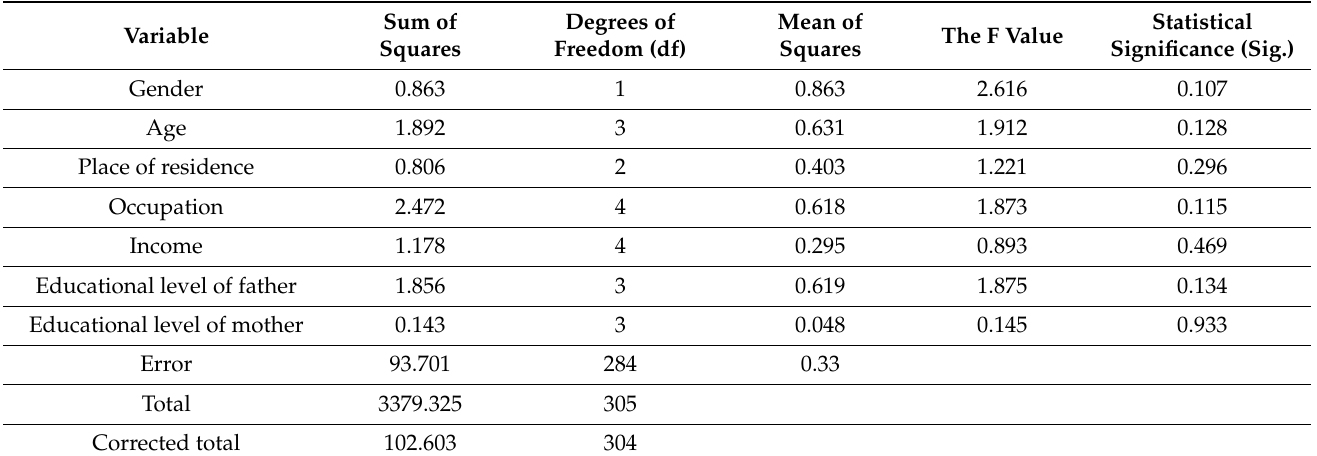
Table 5. MANOVA test of the difference in the level of the familial factors that reinforce volunteering culture in youths when considering the demographic variables.